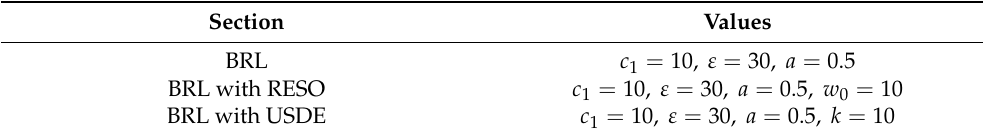
Figure 10. Tracking results of the system with mismatched uncertainty under the sinusoidal signal. Table 3. Parameters of the presented control algorithm.